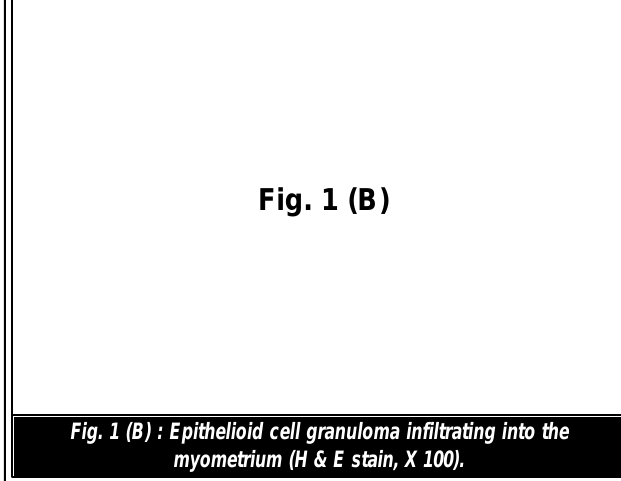
Fig. 2 : Section from ovarian mass showing epithelioid cell granuloma with caseous necrosis (H & E stain, x 100).